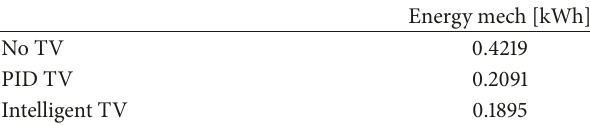
Table 9: Mechanical energy comparison.